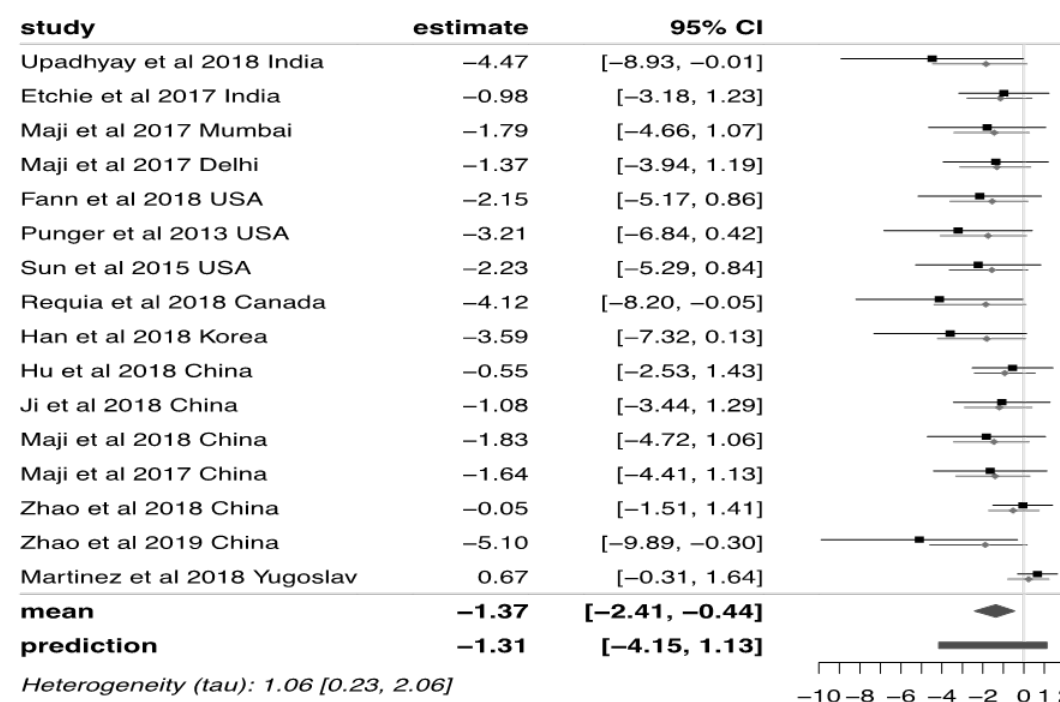
Figure 4. Forest plot PM2.5. The values of the forest plots indicate the log mortality rate mapped to their corresponding normal distribution values.